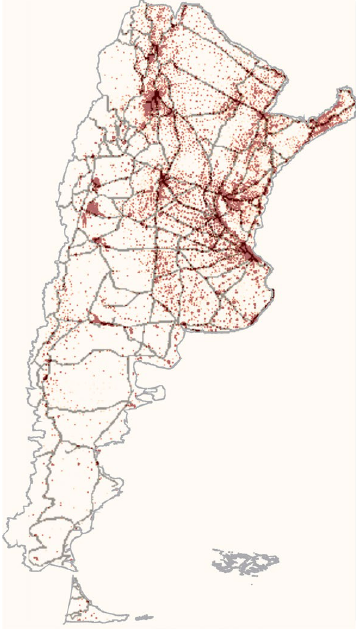
Figure 2. Density map and distribution of routes used in the model. The information to create the maps was provided by the IGN. Each pixel corresponds to a 7 km x 7 km parcel.